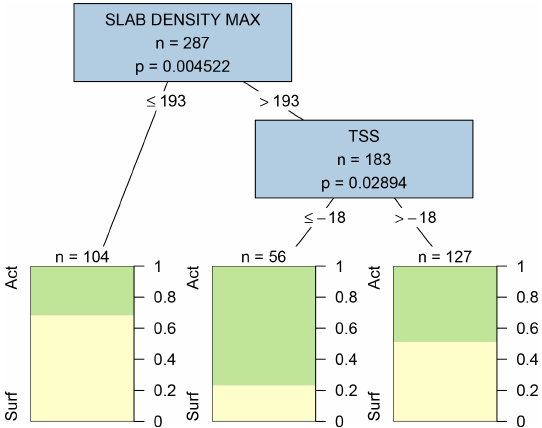
Figure 8. Decision tree comparing conditions before and after weak layers first become associated with persistent problems (considering 3d before they become problems and the first 3d of layers of being associated with a problems). Variables appearing in the tree include the maximum slab density in kgm − 3 (SLAB DENSITY MAX) and the snow surface temperature in ◦ C (TSS). Terminal nodes show the proportion of cases with weak layers having surface (yellow) and active (green) statuses.